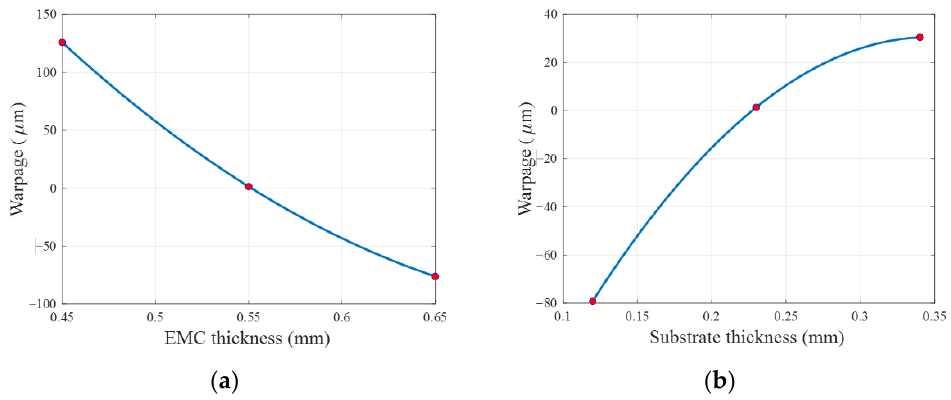
Figure 5. 1D performance functions of two design variables: ( a ) EMC thickness and ( b ) substrate thickness.